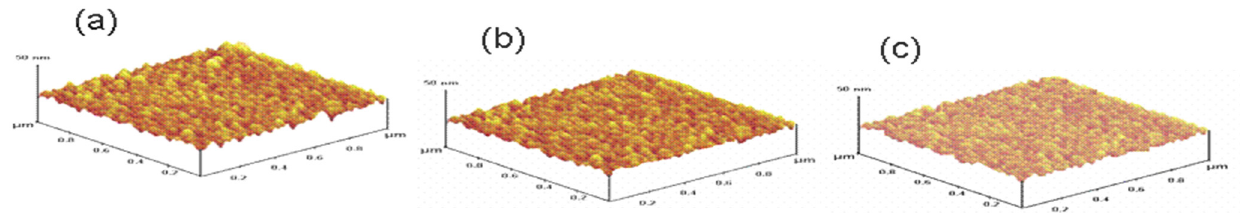
Figure 5. SEM of ( a ) In 2 O 3 and ( b ) (In 0.90 Gd 0.10 ) 2 O 3 thin films and ( c , d ) their histograms.